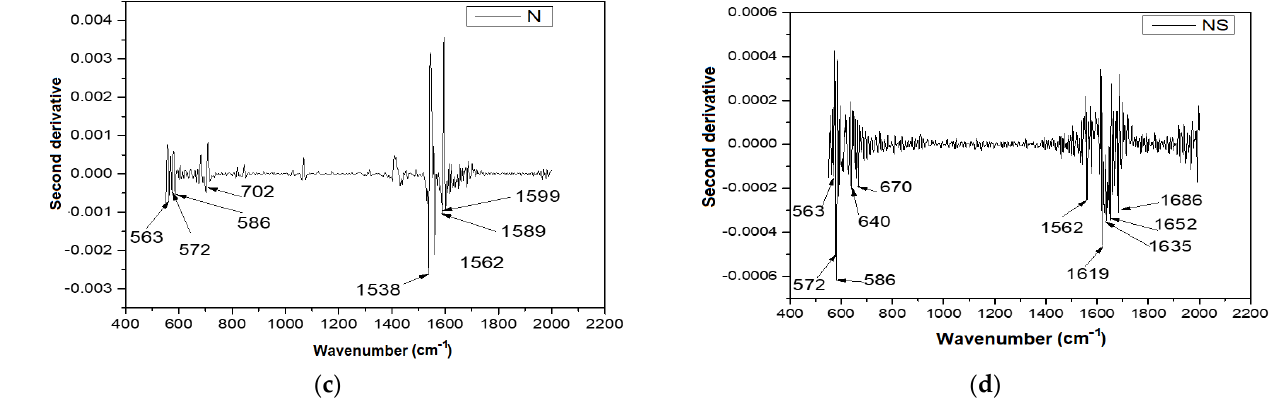
Figure 9. Spectra of absorption in ATR based on the wave number for anaerobically stabilized (N) sludge samples and anaerobic autoclaving (NS) treated anaerobic treatment sludge (NS) ( a ); A2- α derivative of the ATR spectrum according to the wave number for the Nutrient ( b ), N ( c ) and NS ( d ) samples [28].